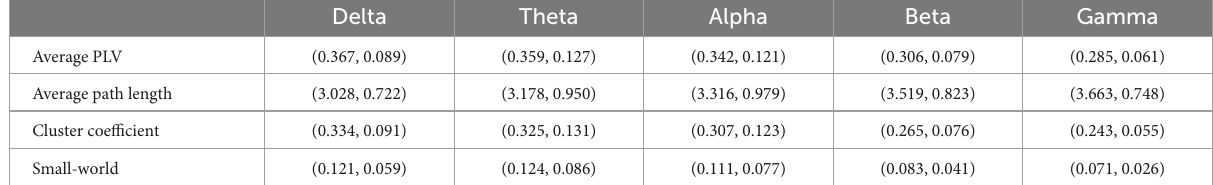
TABLE 2 Average PLV and graphical network parameters (mean value and standard variance) at each frequency band.